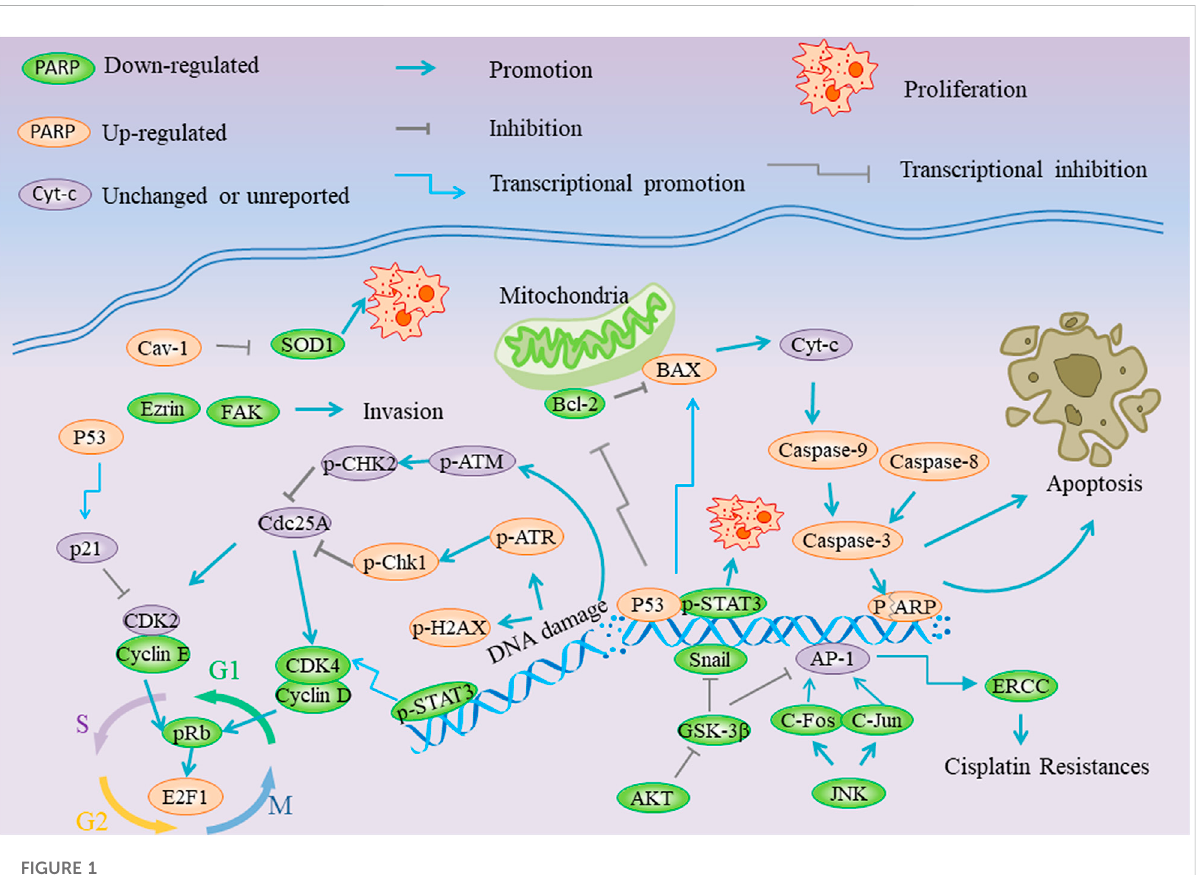
FIGURE 1 Schematic overview of the effects and molecular mechanisms of Sclareol in